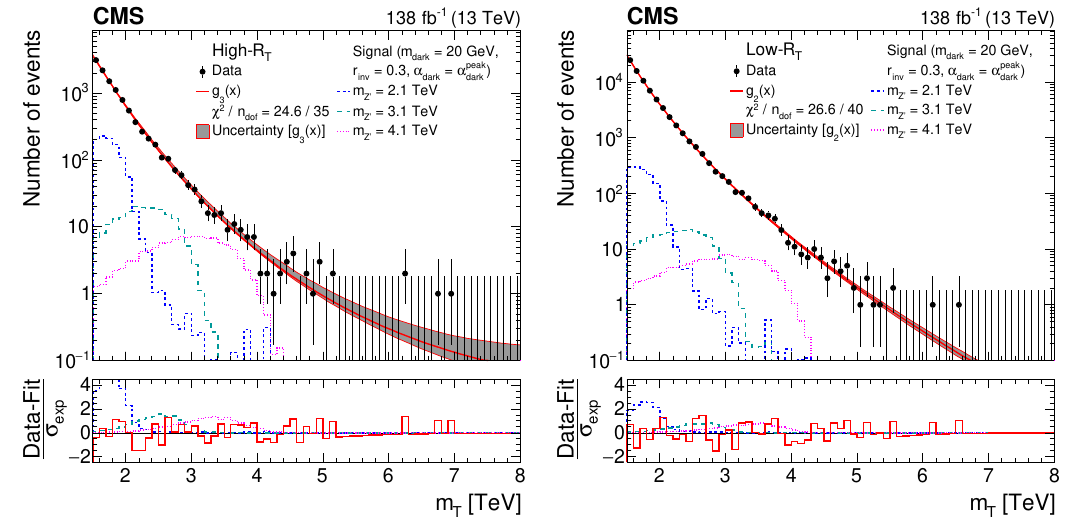
distribution for the high- R (left) and low- R (right) signal regions, comparing Figure 5 . The m T T T the observed data to the background prediction from the analytic fit ( g ( x ) = exp( p x ) x p 2 [1+ p 3 ln( x )] , 3 1 √ ( x ) = exp( p g x ) x p 2 , x = m / s ). The lower panel shows the difference between the observation 2 1 T and the prediction divided by the statistical uncertainty in the observation ( σ ). The distributions exp from several example signal models, with cross sections corresponding to the observed limits, are superimposed.